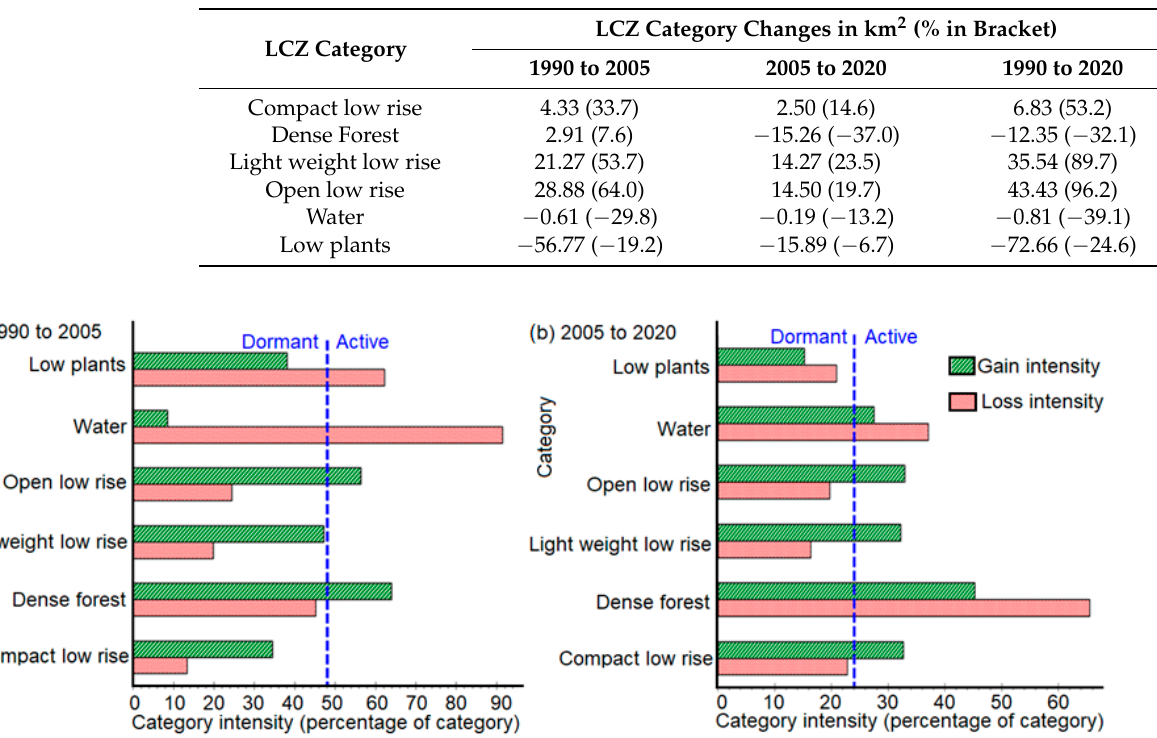
Table 3. LCZ changes from 1990 to 2020 in Bulawayo.